Question: Summarize what this figure shows in one sentence.
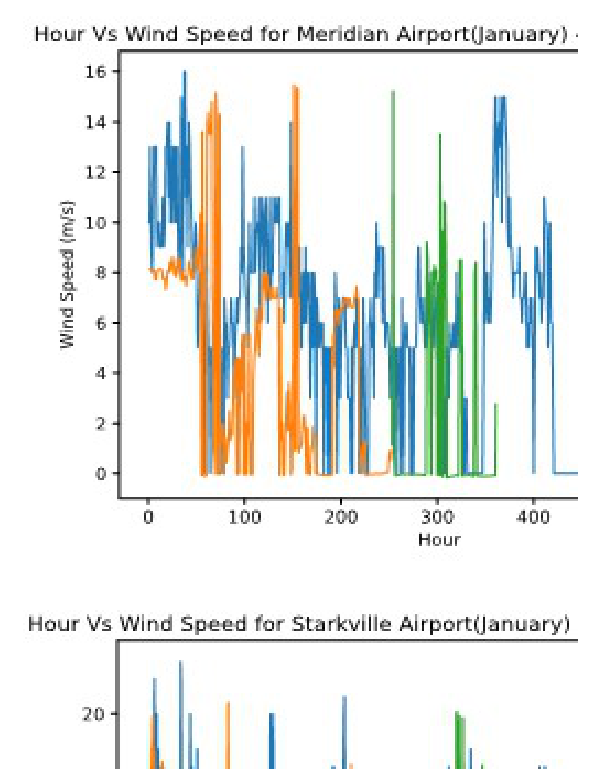
Answer: MERIDIAN VS. STARKVILLE FOR THE MONTH OF